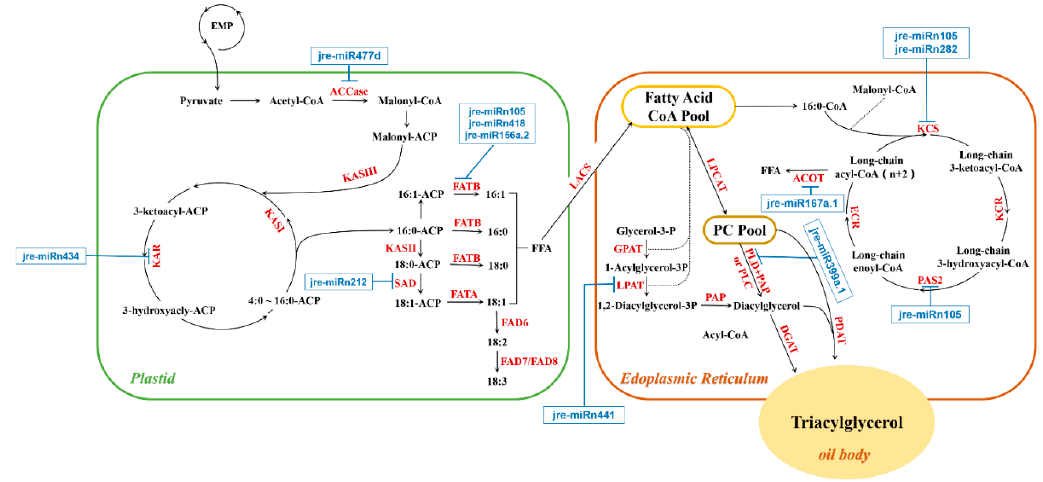
Figure 9. Overview of miRNAs and genes regulation patterns in FA and TAG synthesis pathways. The red letters are genes, and the blue letters are miRNAs.